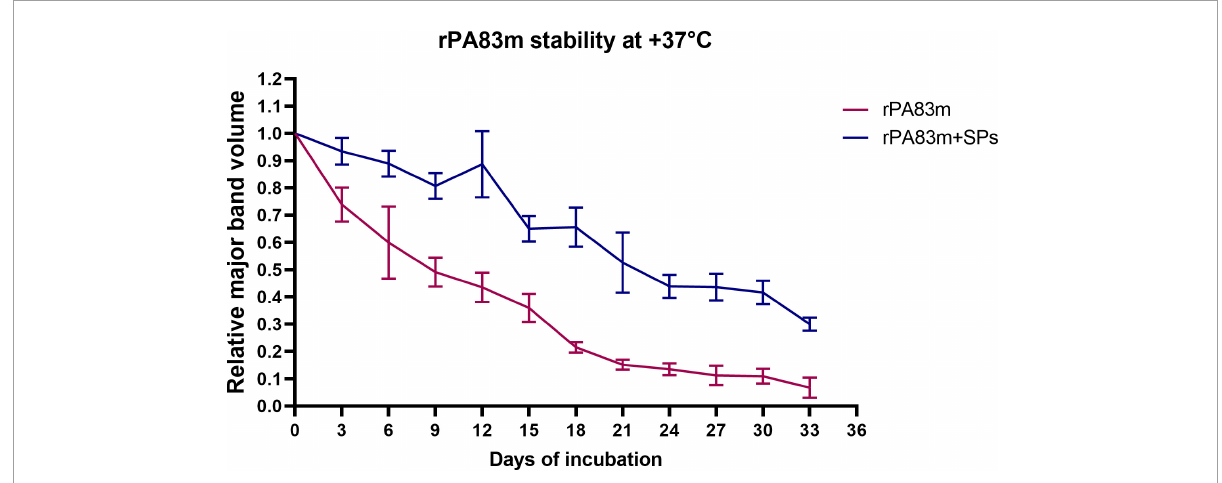
FIGURE1 Stability of individually formulated rPA83m and rPA83m as a part of rPA83m + SPs compositions at +37 ◦ C. Individually formulated rPA83m and rPA83m + SPs compositions were incubated at +37 ◦ C in PBS. In both cases, rPA83m concentration was 1 µ g/ µ l. rPA83m/SPs mass ratio was 1:10. For each checkpoint, relative major band volume means are presented for both individually formulated rPA83m (red) and rPA83m as a part of rPA83m + SPs compositions (blue) (the number of replicates was n = 5). Stability evaluation for all incubated replicates was carried out by 8–20% SDS-PAGE analysis. For each replicate, the mean value of major band volumes determined by comparison with two corresponding non-incubated samples was used for graph plotting and group comparison. Bars represent 95%